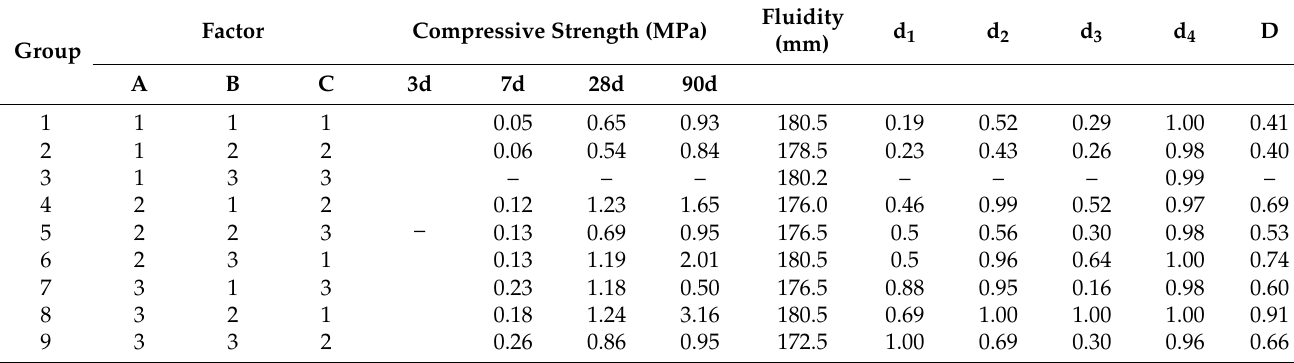
Table 1. Orthogonal test